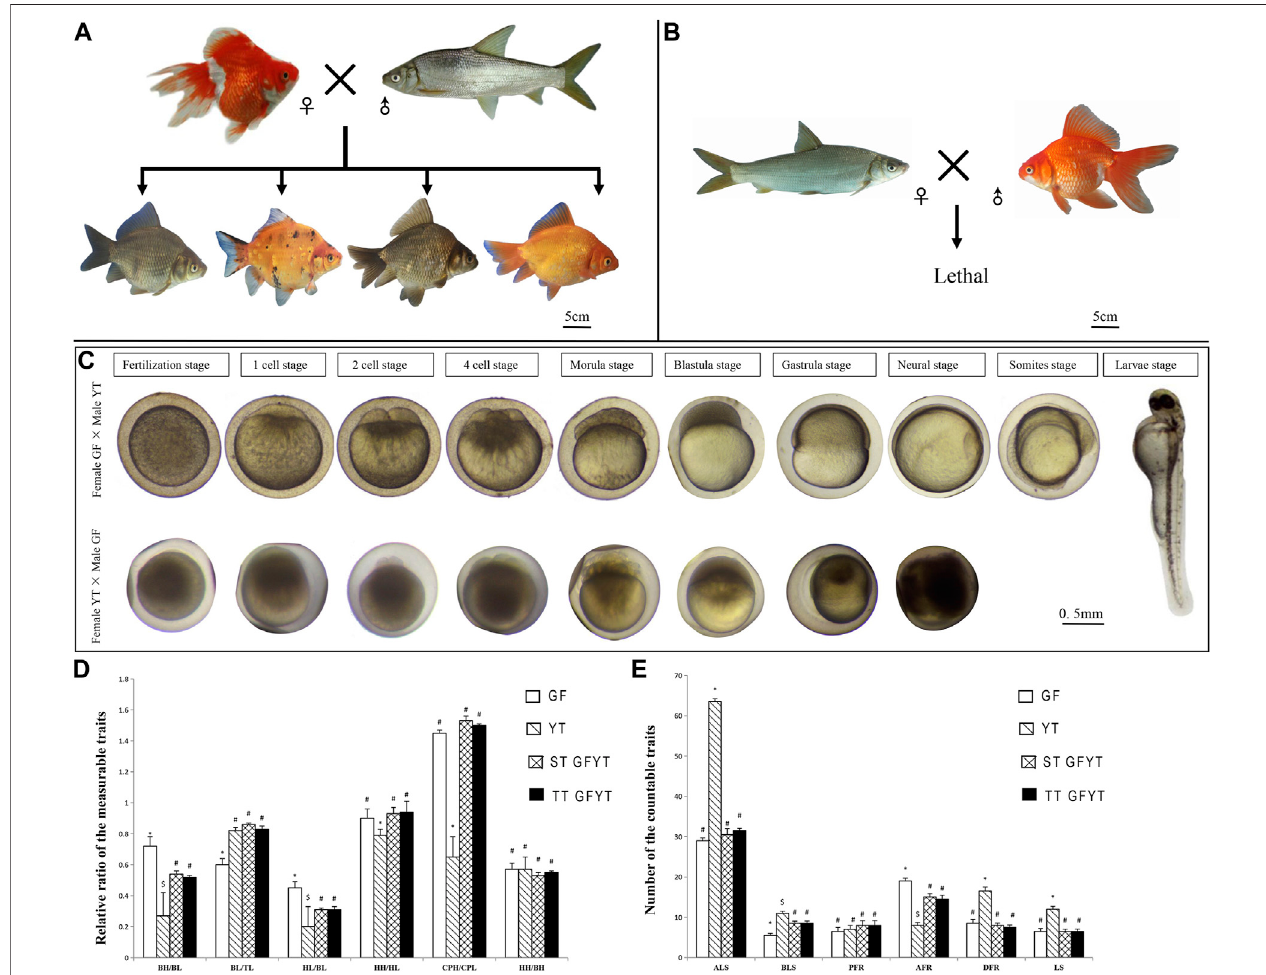
FIGURE 1 | Reciprocal crosses, main stages of embryonic development, and comparisons of morphological traits between GFYT hybrids and their parents. (A) Cross of female GF × male YT and their hybrid offspring. (B) Lethal cross offemale YT × male GF. (C) Main stages of embryonic development of reciprocal crosses. The upper laneshows thecross offemaleGF×maleYT, and thelower presents the crossoffemale YT ×male GF. (D) Comparisons ofthemeasurable traits betweenGFYT andtheirparents. (E) ComparisonsofthecountabletraitsbetweenGFYThybridsandtheirparents.Foreachcomparison,differentsymbols(#or*)meansigni fi cant difference ( p < 0.05). TL, total length; BL, body length; BH, body height; HL, head length; HH, head height; CPL, caudal peduncle length; CPH, caudal peduncle height; LS, lateral linescales; ALS, scale rows above the lateral line; BLS, scale rows belowthe lateral line; DFR, dorsal fi n rays;PFR, pelvic fi nrays; AFR, anal fi n rays;ST, single tail; TT, twin